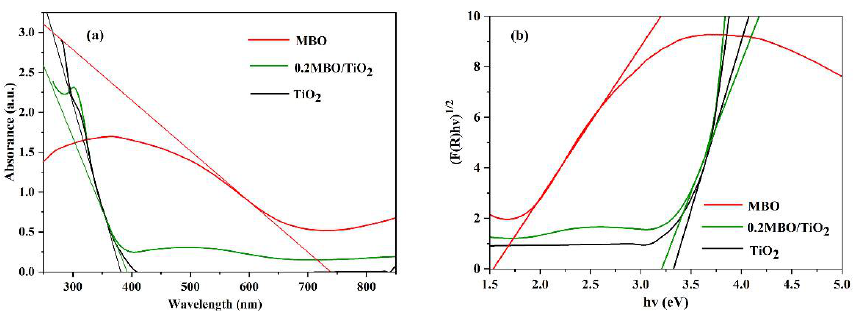
Figure 5. ( a ) UV–Vis DRS and ( b ) the plots of ( F ( R ) hv ) 1/2 versus hv of MBO, TiO 2 and 0.2 MBO/TiO 2